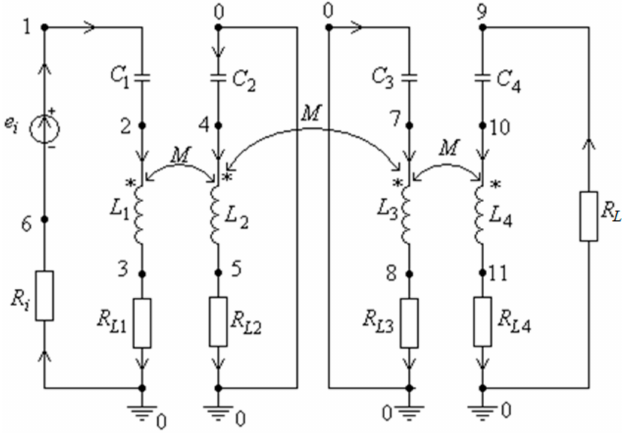
Figure 1. The equivalent circuit of a WPTS with four magnetically coupled